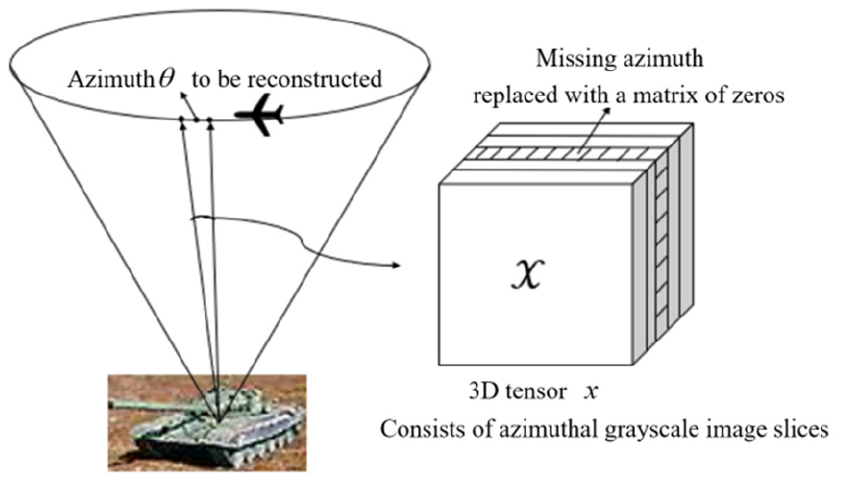
Figure 2. Sparse tensor construction.